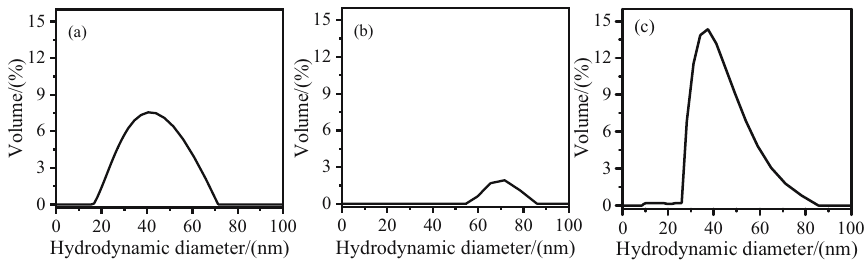
Figure 1: The hydrodynamic diameter distribution of the magnetic NPs at ( a ) 0.5% of DDT - PMAA; ( b ) 1% of DDT - PMAA; and ( c ) 2% of DDT - PMAA,